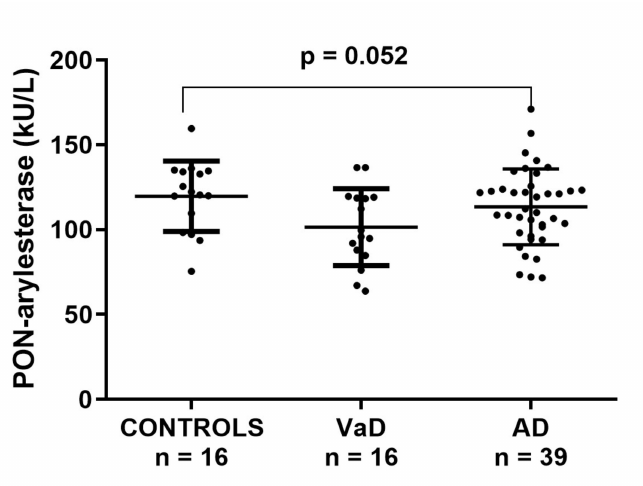
Figure 2. Scatter plots displaying serum PON-arylesterase activity in CONTROLS ( n = 16), VaD ( n = 16), and AD ( n = 39) patients, within ADC. Statistical analysis was performed using ANOVA followed by Sidak post-hoc test. Abbreviations: VaD, vascular dementia; AD, Alzheimer’s disease; PON,